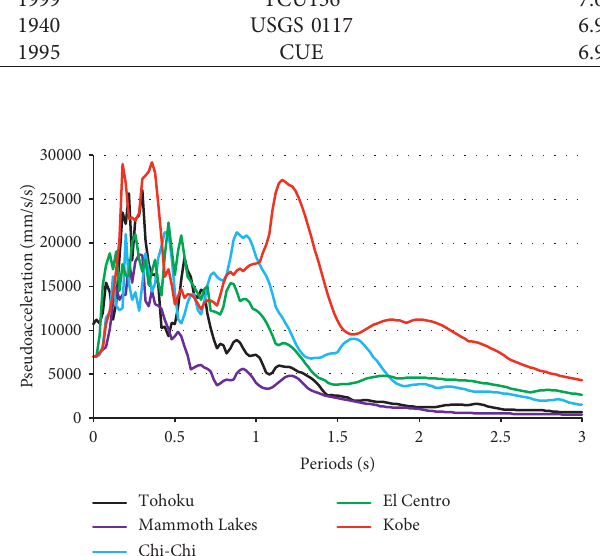
Figure 16: Pseudoacceleration response